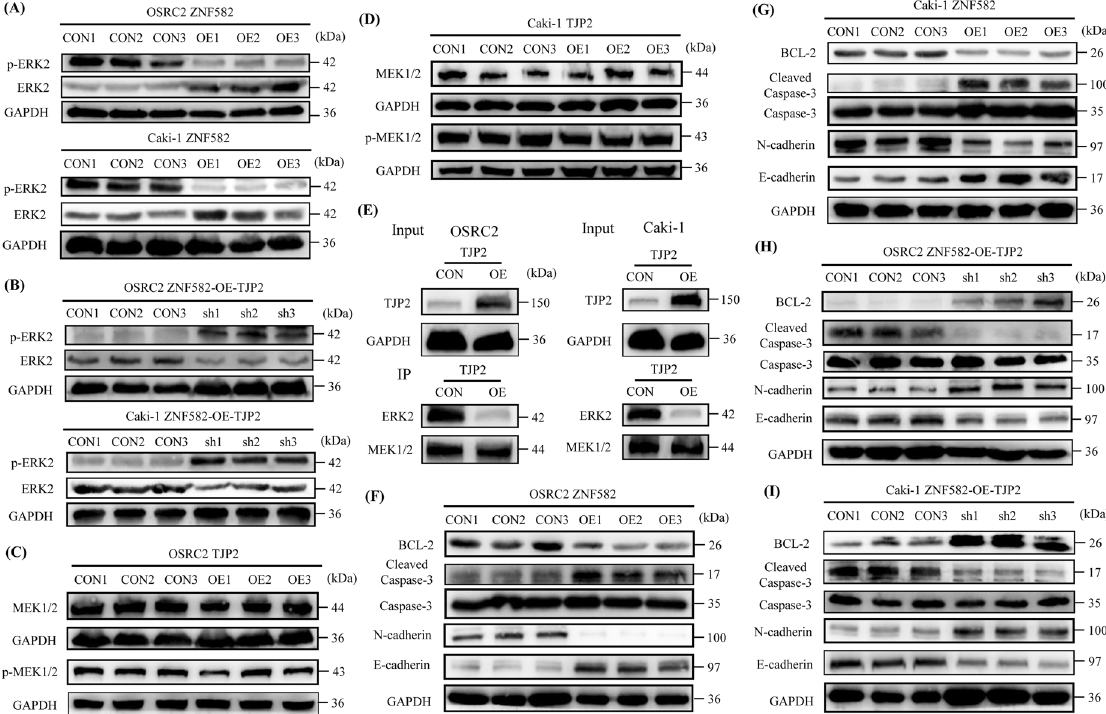
Fig. 5 Combination of TJP2 and ERK2 inhibits ERK2 phosphorylation. A Detection of p-ERK2 protein expression in ZNF582 overexpression and control OSRC2 and Caki-1 cells. B Detection of p-ERK2 protein expression in TJP2 knockdown and control OSRC2 and Caki-1 cells. C , D Detection of MEK1/2 and p-MEK1/2 protein expression in TJP2 overexpression and control OSRC2 and Caki-1 cells. E Detection of the expression of ERK2 binding to MEK1/2 in TJP2 overexpression and control OSRC2 and Caki-1 cells. F , G Comparison of the expression of BCL-2, Cleaved Caspase-3, N-cadherin and E-cadherin between ZNF582 overexpression and control OSRC2 and Caki-1 cells. H , I Comparison of the expression of BCL-2, Cleaved Caspase-3, N-cadherin and E-cadherin between TJP2 knockdown and control OSRC2 and Caki-1 cells.